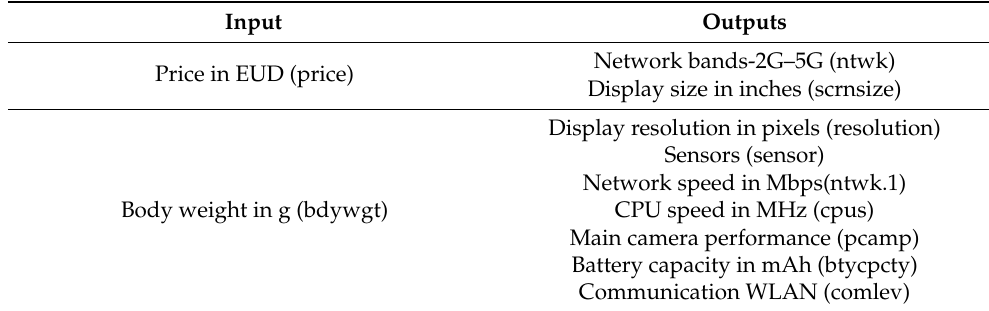
Table 2. Selected inputs and